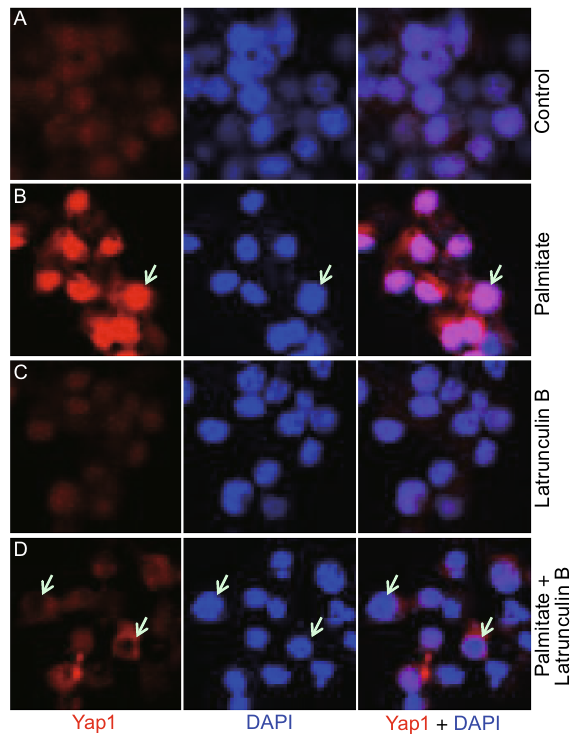
Figure 3. FFA-induced Yap1 nuclear localization is dependent on F-actin. Rat INS-1 832/13 cells were starved in the absence of serum for 12 h followed by the 24-h treatment with palmitate or/and Latrunculin B. (A) Control with solvents, DMSO and ethanol; (B) Palmitate (0.3 mmol/L); (C) Latrunculin B (1 µg/mL); (D) Palmitate (0.3 mmol/L) together with Latrunculin B (1 µg/mL). Yap1 was detected by an anti-Yap1 antibody through immunos- taining. DAPI stains nucleic acids and served as a nuclear marker. White arrows show examples of nuclei that accumulate high levels of Yap1 in (B), or avoid Yap1 nuclear localization in